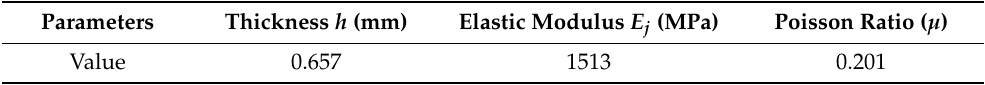
Table 7. Parameters identification results.